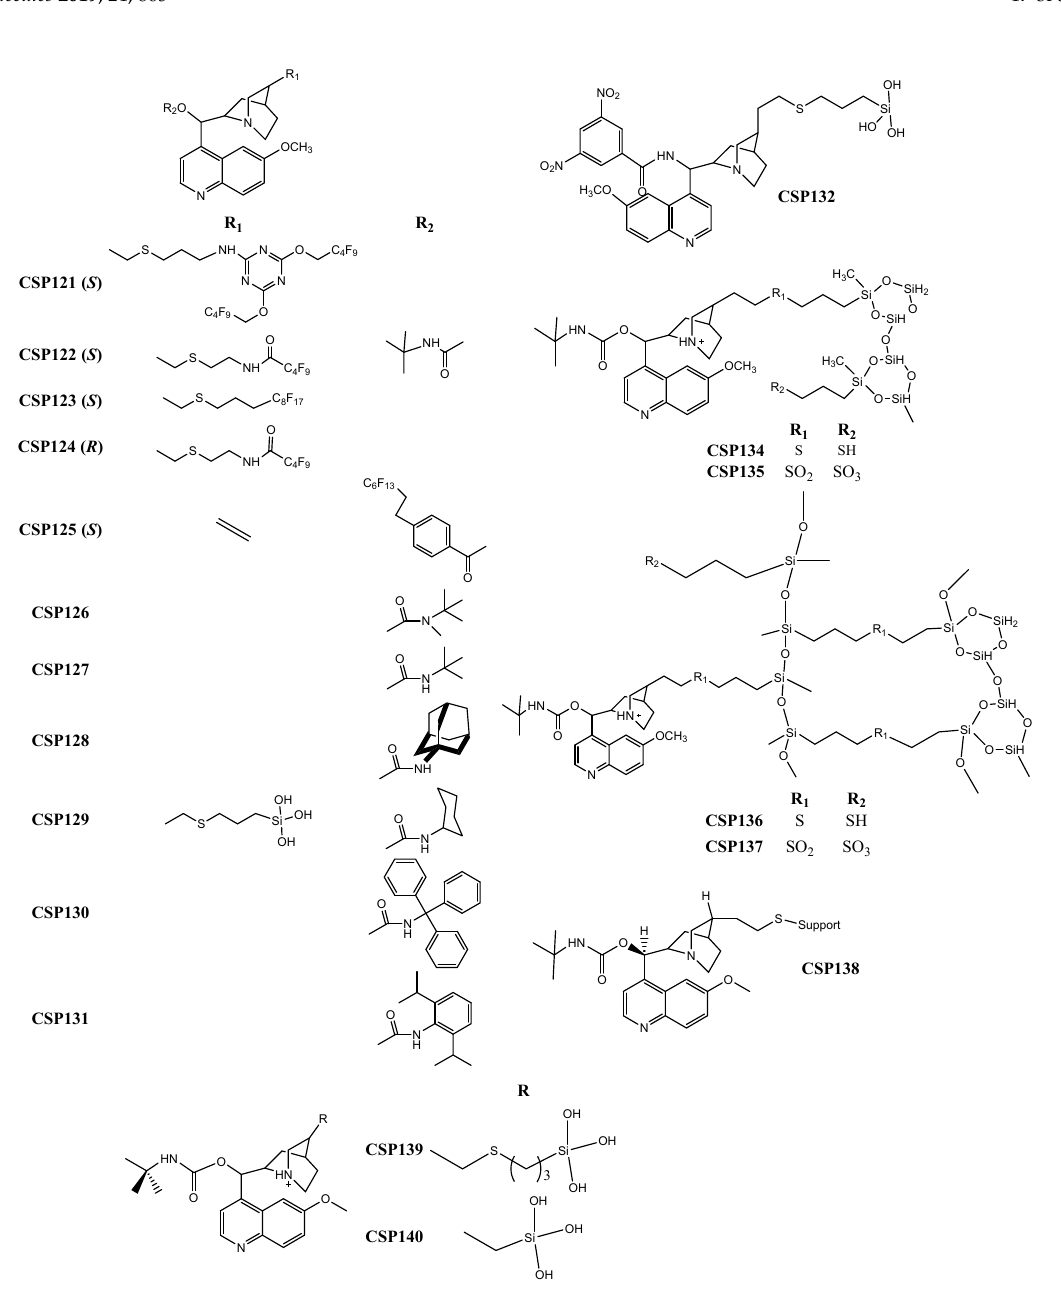
Figure 5. Chemical structures of Ion-exchange-type CSP132–140.